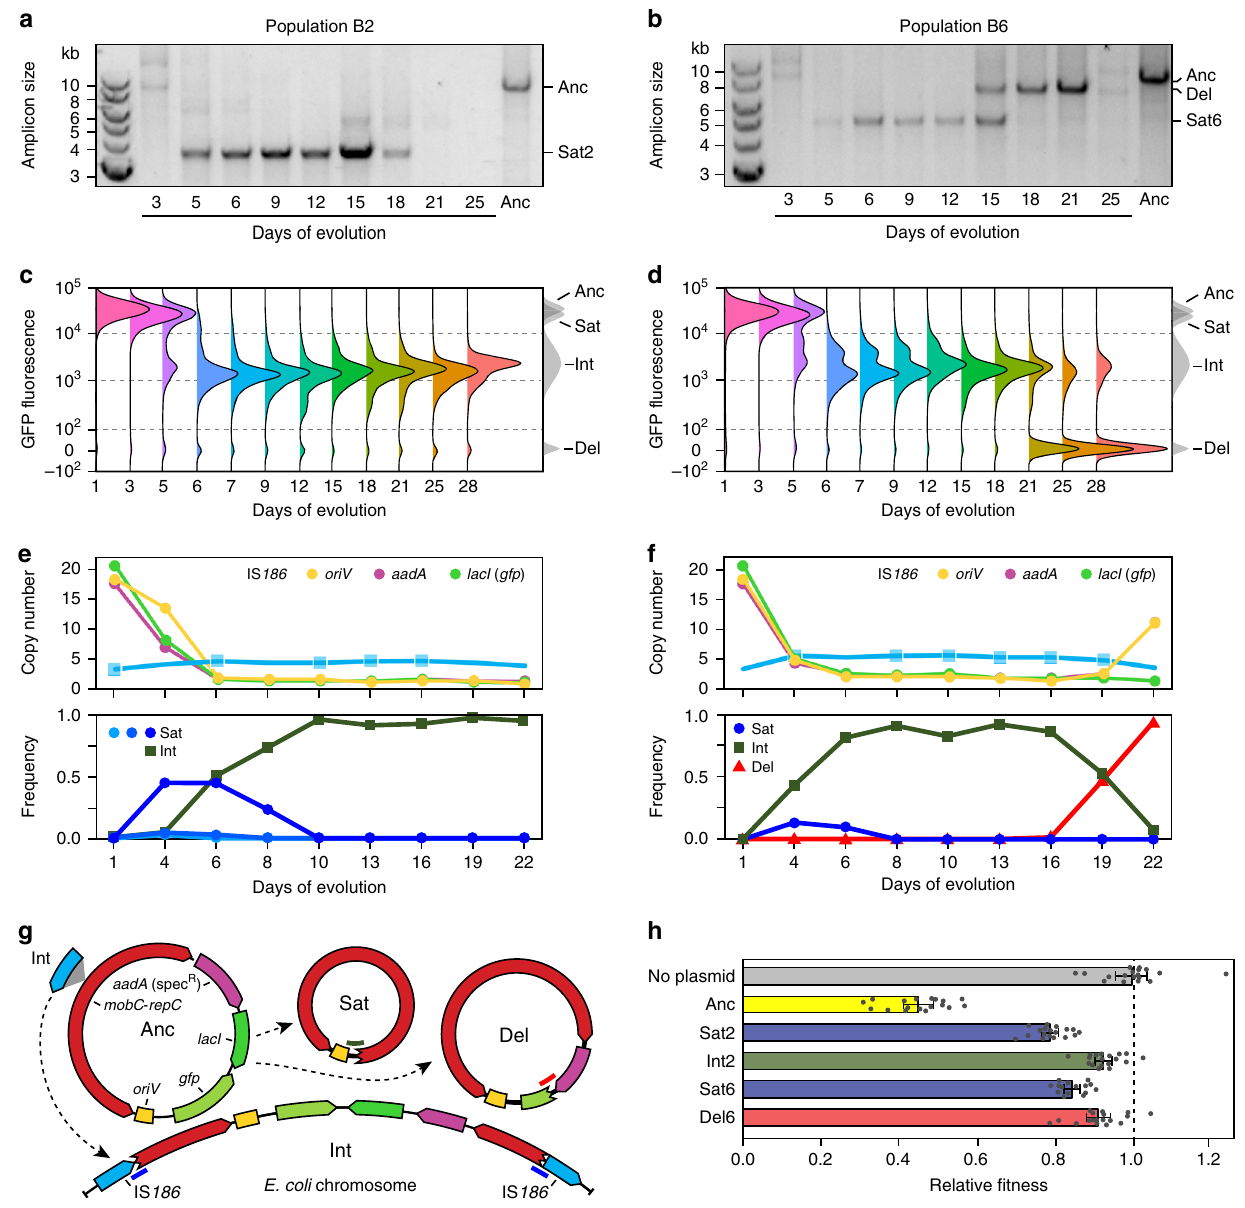
Fig. 2 Time courses of plasmid evolution in E. coli . a , b Appearance and persistence in populations B2 and B6 of satellite plasmids and other evolved plasmids with deletions that also change the size of the linearized plasmid PCR amplicon. Compared to the methods shown in other panels, the PCR assay is biased toward detecting satellite plasmids versus other plasmid fates even when they are very rare in a population because they produce smaller amplicons. c , d Distributions of GFP expression in cells in each population determined using fl ow cytometry. e , f Estimates of the copy numbers of different plasmid regions and the relative frequencies of different evolved plasmids ’ fates in each population from Illumina sequencing data. Coverage of the lacI gene was used to monitor the copy number of intact gfp gene copies because lacI is completely deleted in all evolved plasmids, but gfp is only partially deleted in some plasmids. The x -axes are categorical rather than linear in c – f , with even spacing of all samples that were analyzed from different days. g Schematic showing different evolved fates of the pQGS plasmid. Bold lines in blue, red, and dark green show the locations of sequencing reads unique to integrated, deletion, and satellite plasmids, respectively, which were used to estimate their relative frequencies. h Relative fi tness of strains reconstructed with different evolved plasmid variants determined using co-culture competition assays versus a control strain with no plasmid. Error bars are 95% con fi dence intervals based on 15 – 18 replicate measurements for each strain. Source data are provided as a Source Data fi